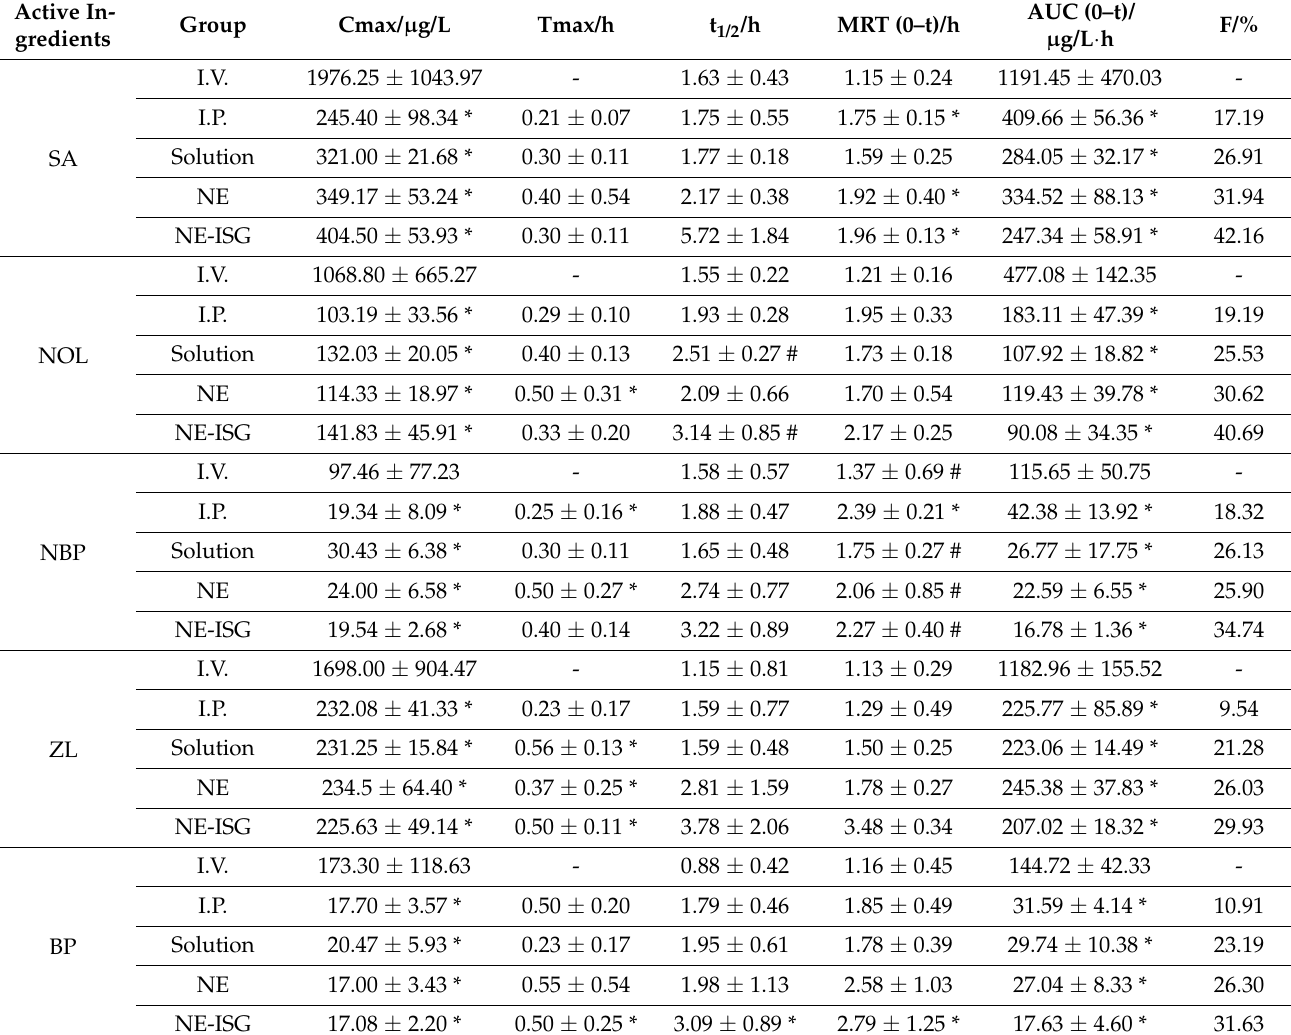
Table 2. Table of pharmacokinetic parameters of plasma sample of each index component in each group ( n = 6, X ± SD).